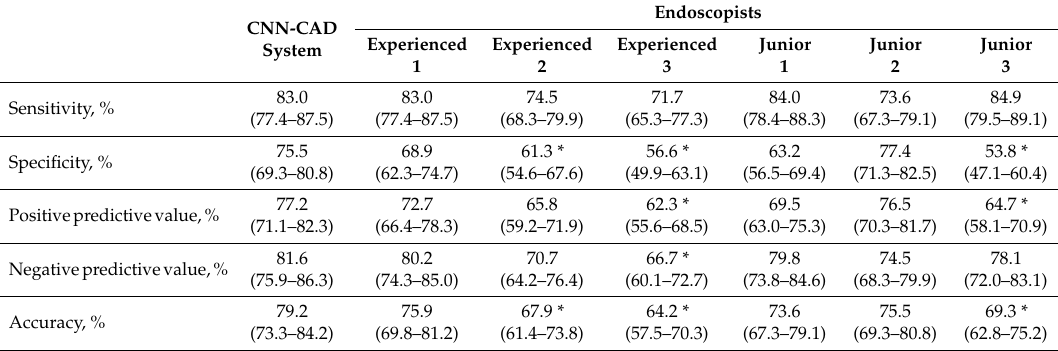
Figure 2. Receiver operating characteristic curve for the test dataset. The area under the curve is 83.4%. Table 2. Diagnostic performance of a convolutional neural network computer-aided detection system compared to that of endoscopists in di ff erentiating gastrointestinal stromal tumors (GISTs) from non-GIST